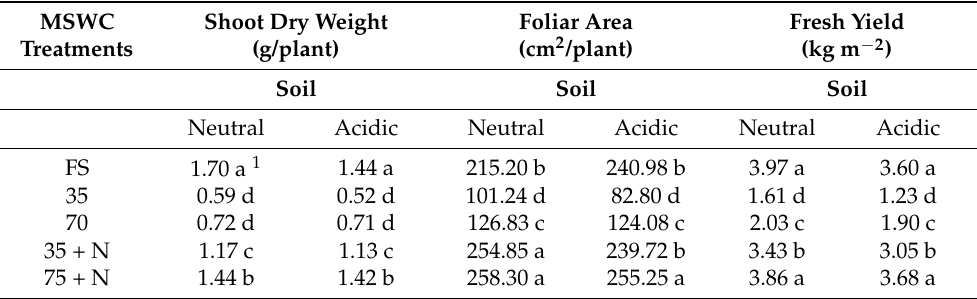
Table 4. Effects of soil and MSWC supplemented or not with inorganic nitrogen on shoot dry weight, foliar area, and fresh yield of